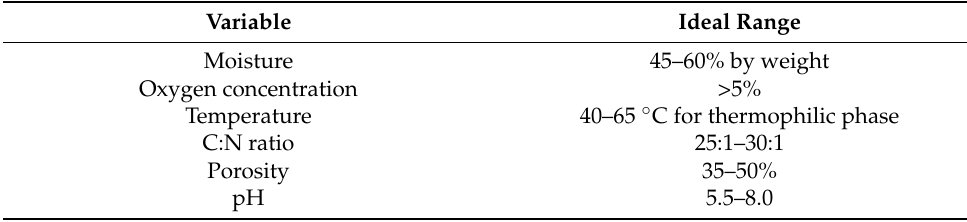
Table 1. Ideal range of several important factors of